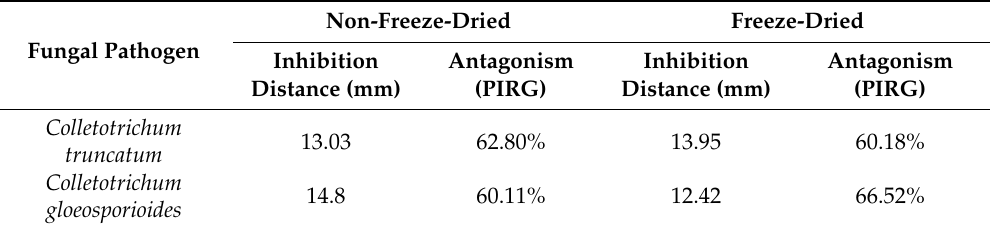
Figure 3. In vitro antifungal activity of P. polymyxa Kp10 against (a) C. truncatum and (b) C. gloeosporioides. Table 4. Antifungal activity of non-freeze-dried and freeze-dried P. polymyxa Kp10 against fungal pathogens in dual culture after five days growth.